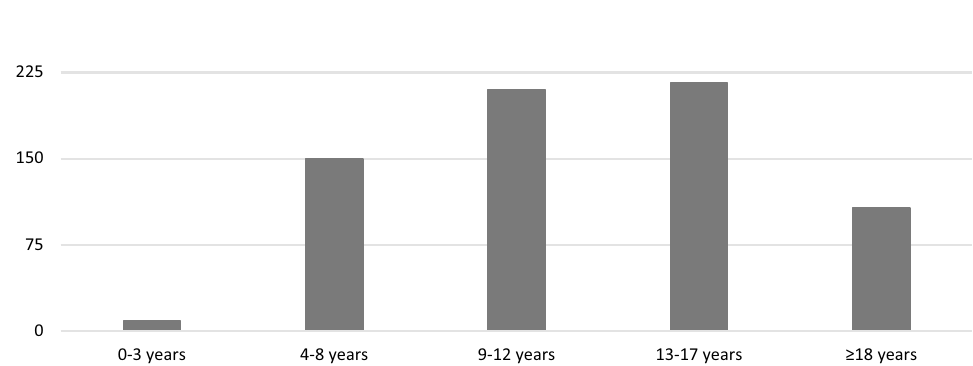
Fig. 5 Overview of the number of articles that included pediatric patients in a specific age